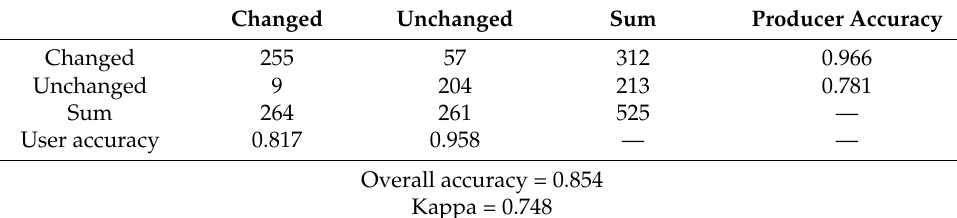
Table 3. Change detection accuracy of pixel-based Landsat satellite